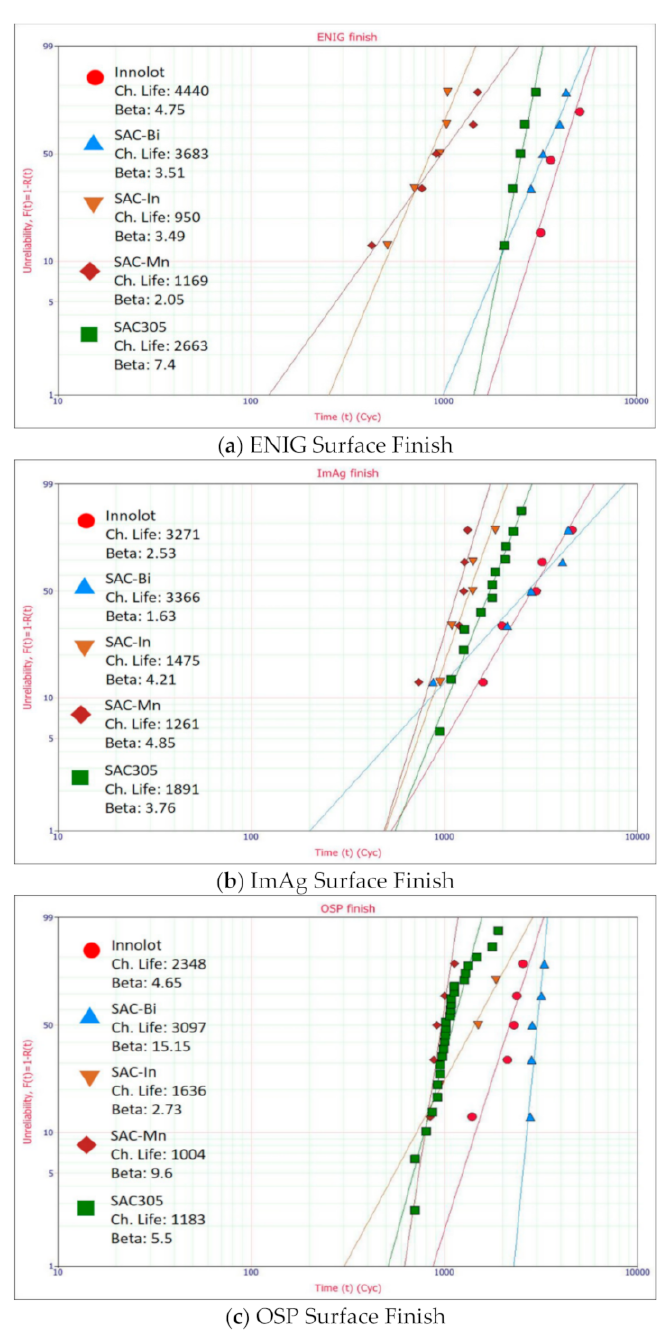
Figure 5. Weibull analysis for different alloys with; ( a ) ENIG; ( b ) ImAg; and ( c ) OSP surface